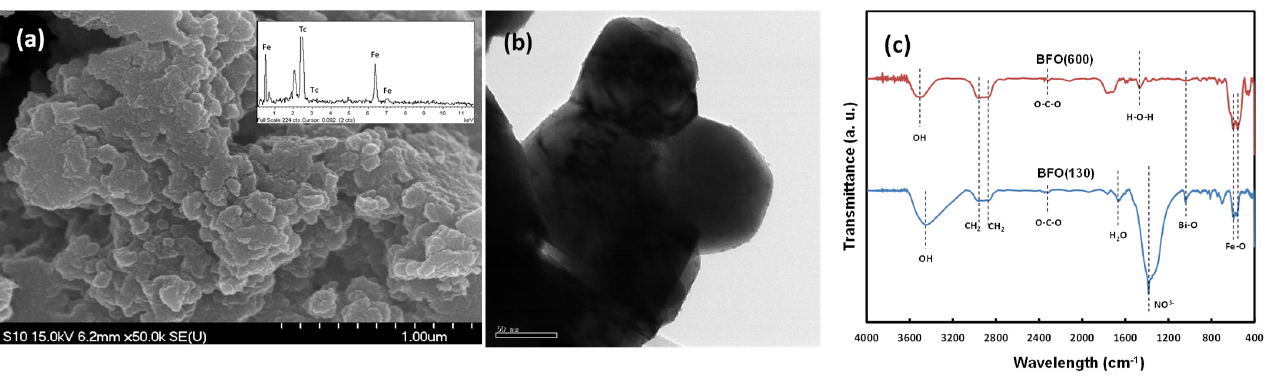
Figure 2. ( a ) SEM image with EDS results, ( b ) TEM image, and ( c ) FT-IR spectra of BF. X-ray photoelectron spectroscopy (XPS) was performed to confirm the surface state of the synthesized BF nanoparticles. Figure 3 illustrates the entire XPS spectra of the BF photocatalyst. The peaks for BF, such as Bi 4 f 7 , Bi 4 f 5 , Fe 2 p 1 , C 1 s , Fe 2 p 3 , and O 1 s were observed. The C 1 s peak was also observed in the entire spectra, but the C adsorbed on the BF surface does not influence the physicochemical properties of the composites [39].